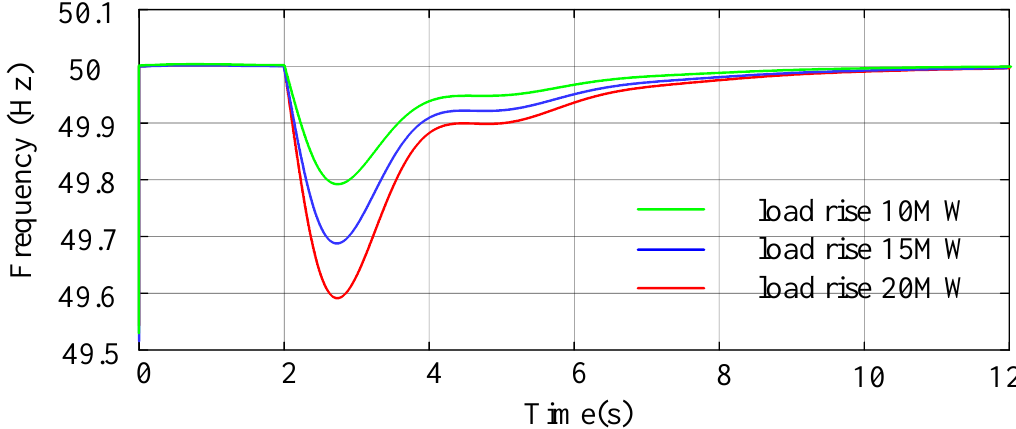
Figure 23. System frequency regulation result of high wind speed.